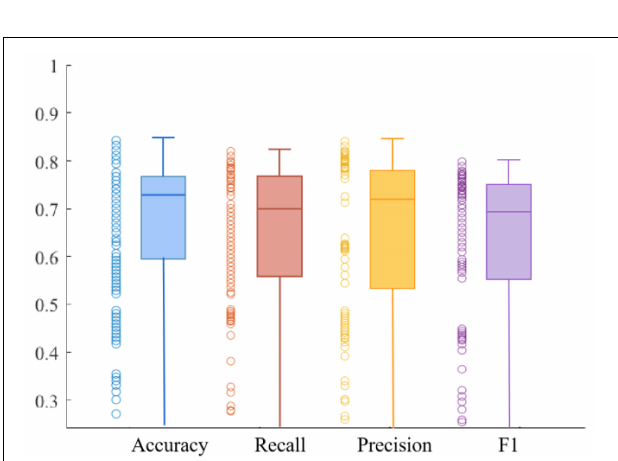
FIGURE 11 | Combination of scatter plot and box plot of validation set.